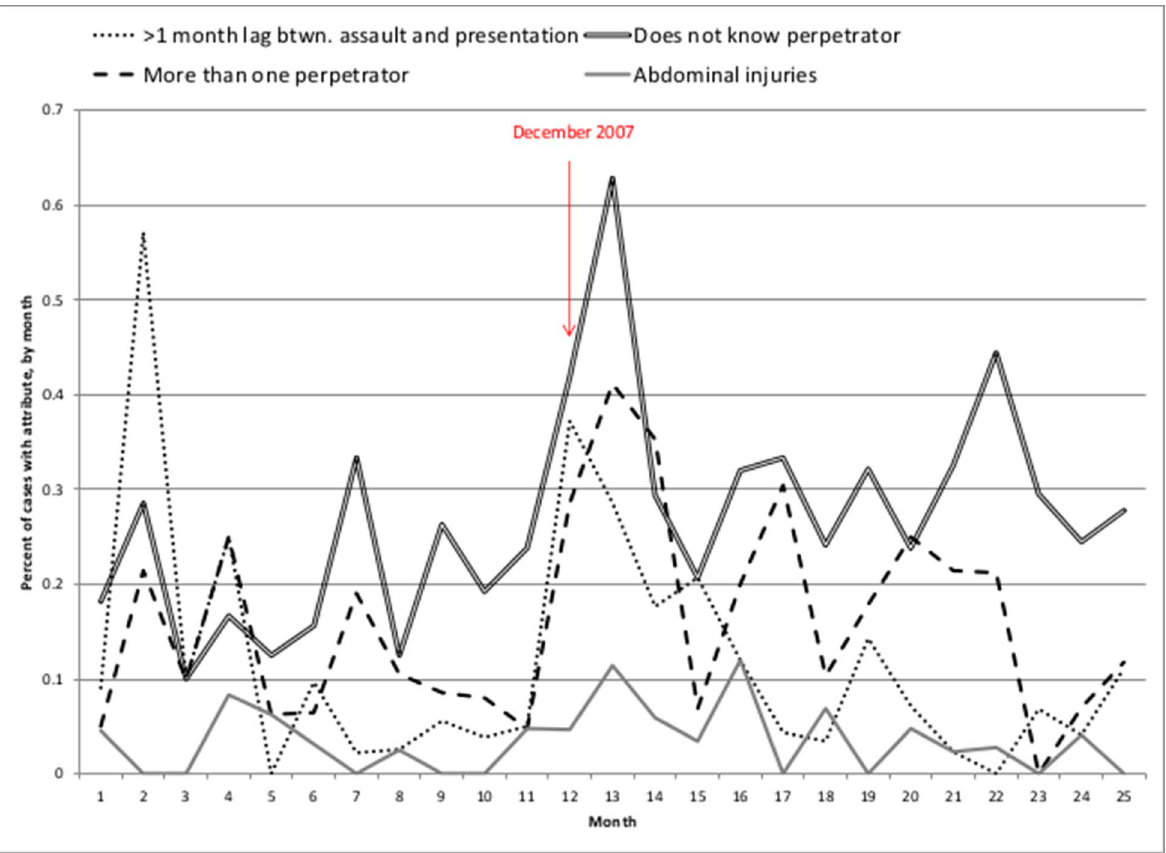
Figure 1. Percent of cases with significant characteristic, by month (January 2007–January 2009)*. *Series has been abbreviated to display multiple characteristics during PEV period.